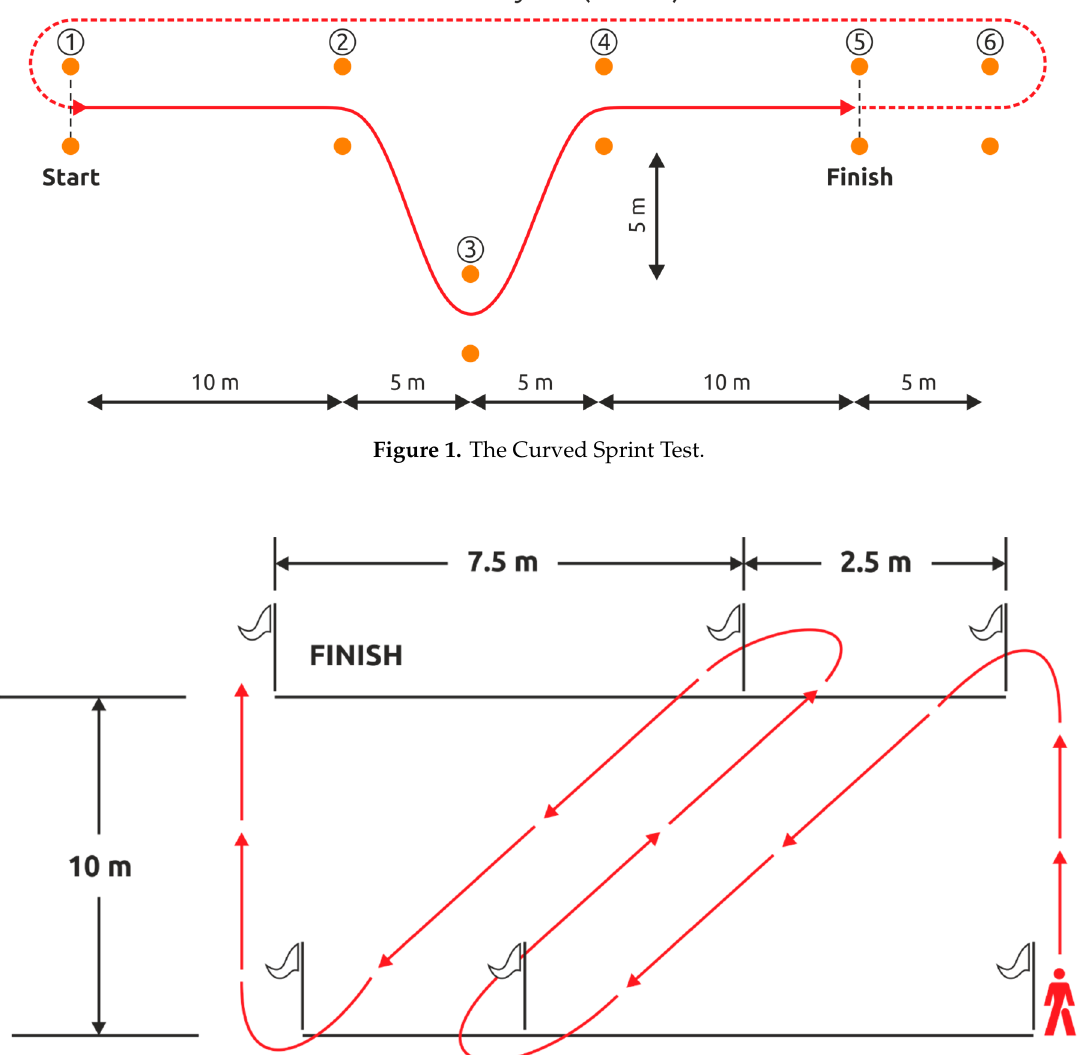
Figure 2. The Ajax Shuttle Test.